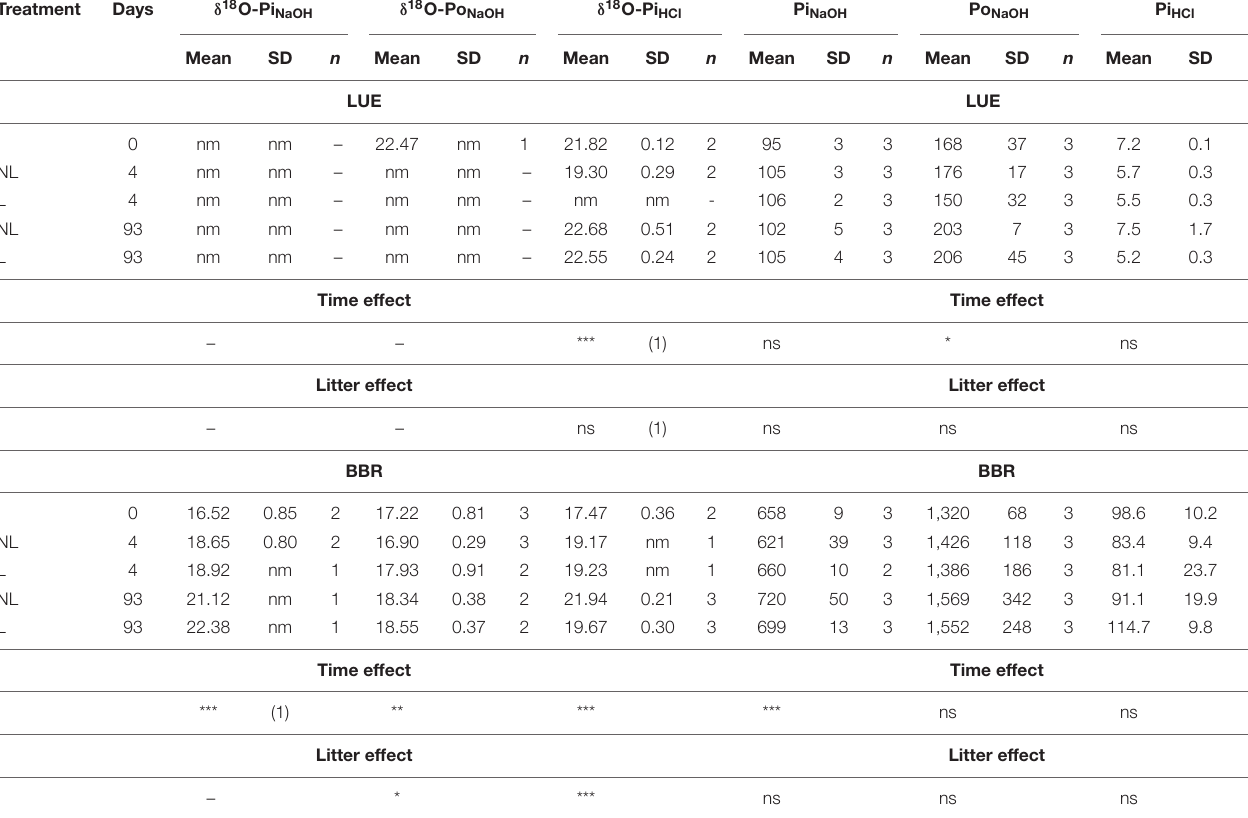
TABLE 2 | Concentration and δ 18 O-P values of inorganic and organic P pools over the incubation period. Treatment Days δ 18 O-Pi NaOH δ 18 O-Po